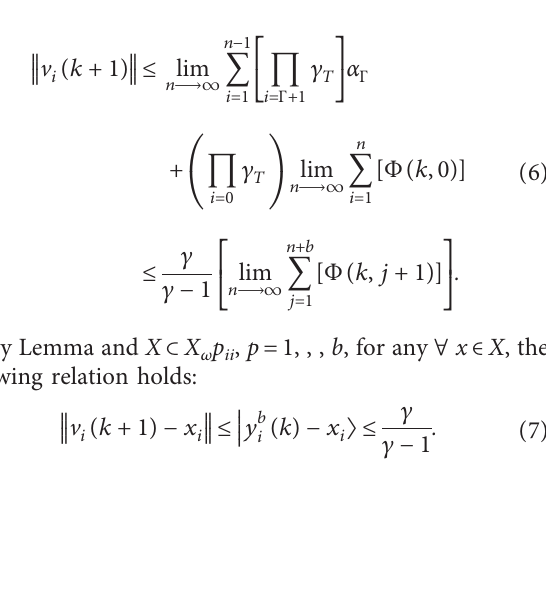
Figure 2: Random time delay model: there are various possible times for a message to travel from j to i